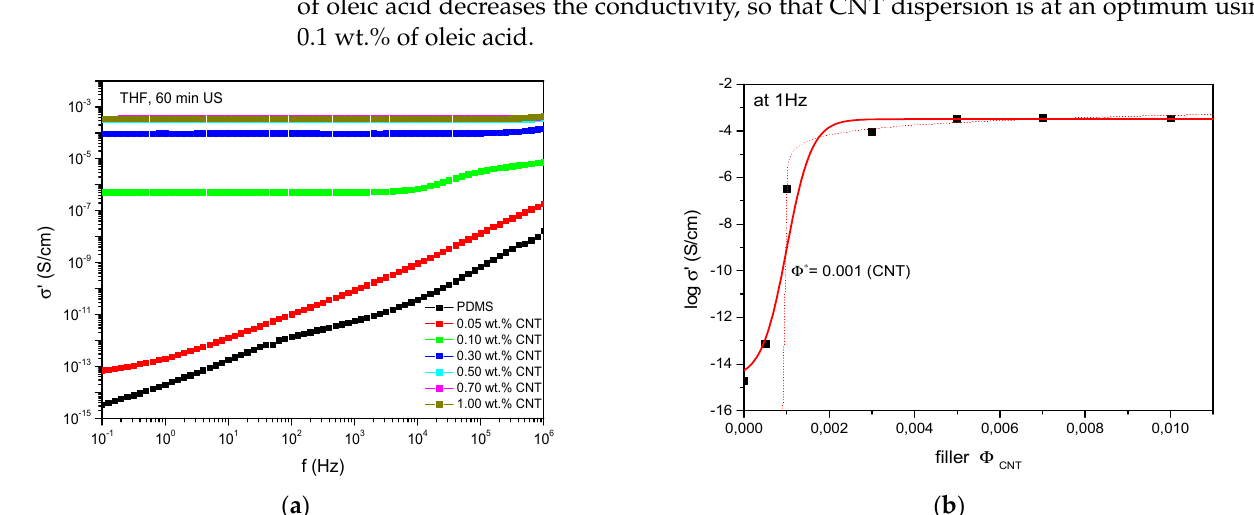
Figure 4. ( a ) Electrical conductivity depending on pretreated CNT concentration and ( b ) estimation of electrical percola- tion threshold.